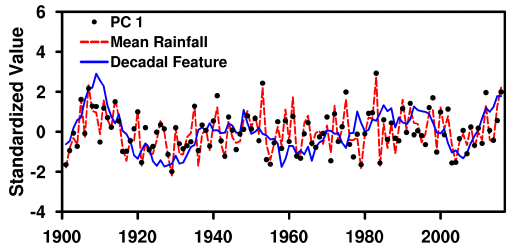
Figure 3. Standardized time series of all dry season precipitation over eastern China as shown by the red dashed line. The black dots denote flipped PC1 and the blue lines denote the decadal features of dry season precipitation.